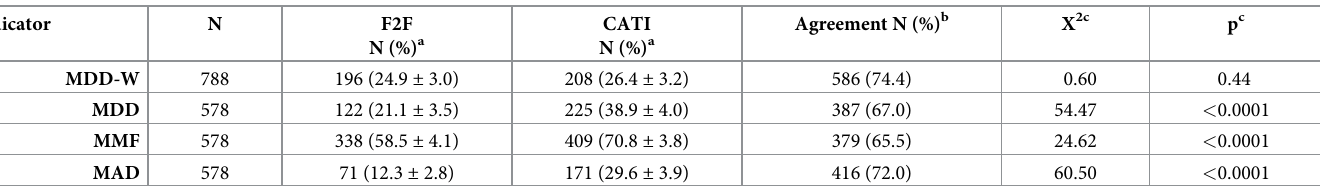
Table 2. Changes in nutrition indicators with data collection mode.